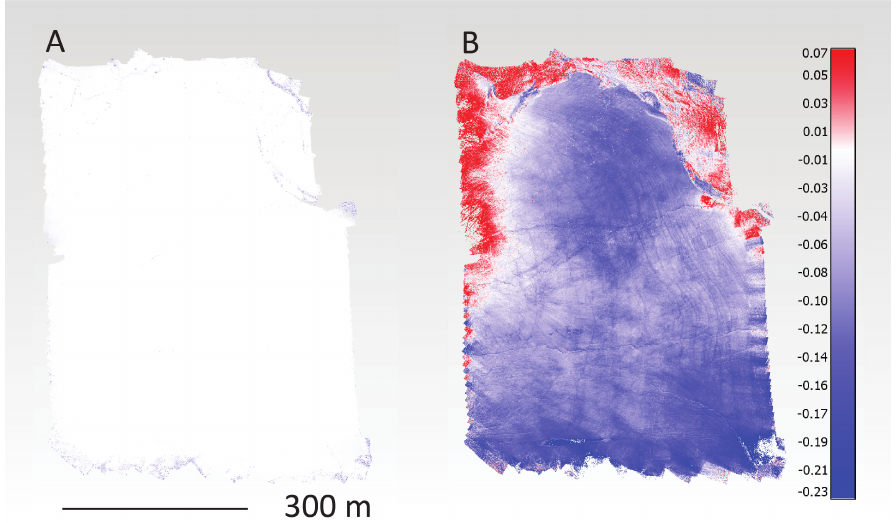
Figure 3. ( A ) After differencing the 21 and 23 July July point clouds, values removed in the filtering process, which had M3C2 dist values more than two standard deviations from the mean, were clustered along the edges of the point cloud (blue points). ( B ) After filtering the 21–2 July M3C2 results, 53% of points were retained for analysis with a mean distance of − 0.081 m. Values above zero are shown in red, while values below zero (showing surface lowering) are in